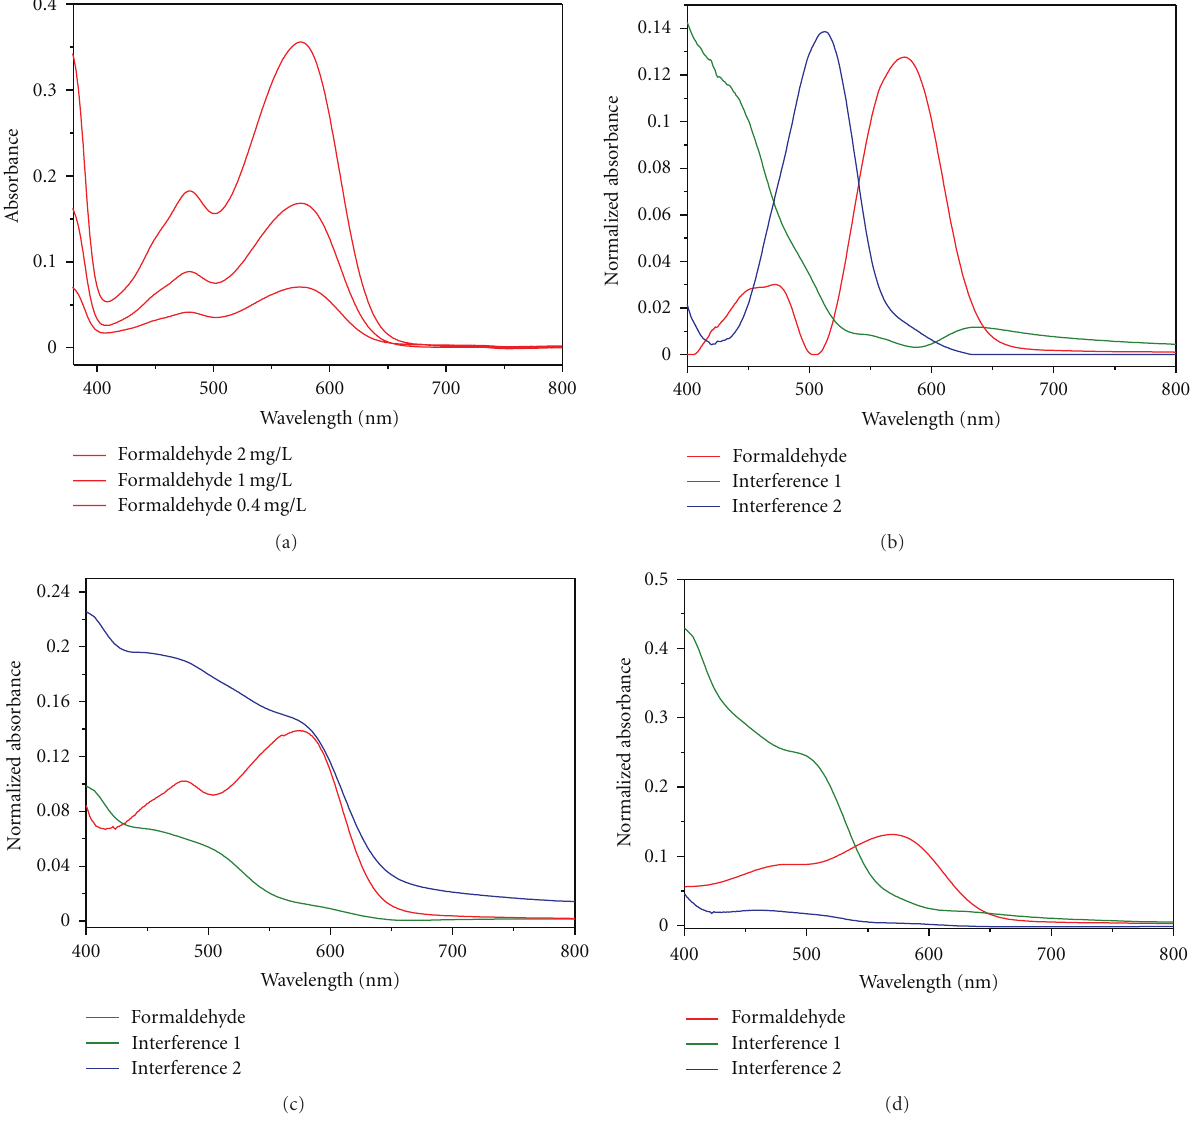
Figure 7: Experimental pure formaldehyde spectra (a) and resolved MCR-ALS (b), MILCA (c), and SIMPLISMA (d) spectra of formaldehyde and two